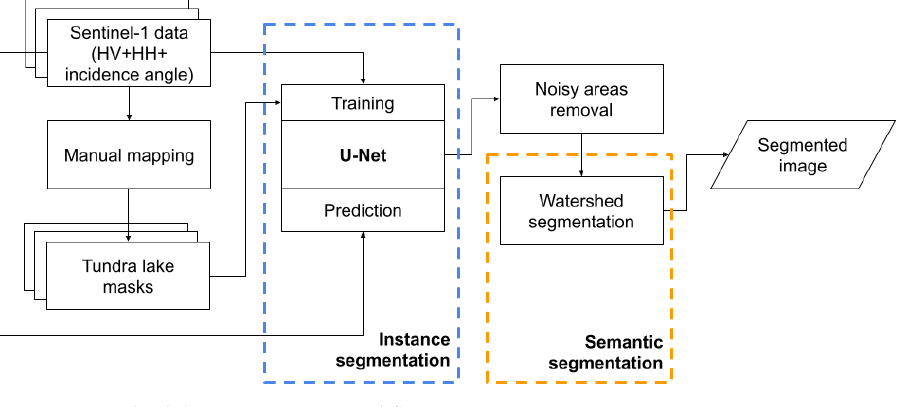
Figure 4. Tundra lakes recognition